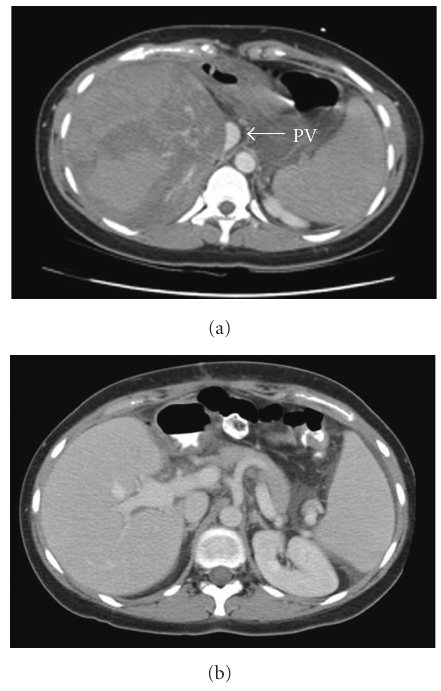
Figure 1: (a) CT scan demonstrating extensive intraparenchymal hematoma and compression of portal vein (PV) branches; (b) for comparison, a CT scan from the same patient from 2 years prior shows the normal appearance of a right lobe graft with normal portal vein branches.